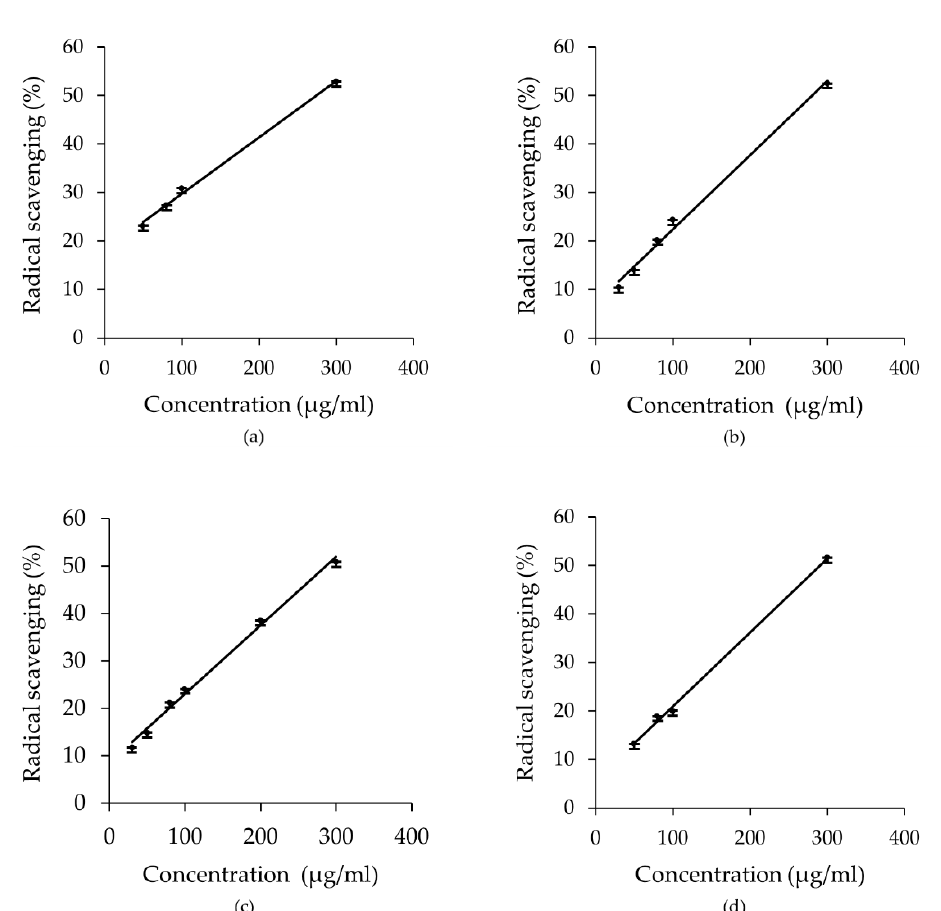
Figure 10. Dose-dependent ABTS (%) radical scavenging activity of E. foeminea crude extracts. ( a ) Acetone; ( b ) dichloromethane/methanol; ( c ) ethanol; ( d ) ethyl acetate; ( e ) methanol; ( f ) ascorbic acid as control. Pearson correlation coefficients (r) between concentrations and % radical scavenging activity were found to be 0.9735, 0.9969, 0.9970, 0.9988, and 0.9995, respectively. Values are the means of triplicate analyses; error bars denote the relative standard deviation.